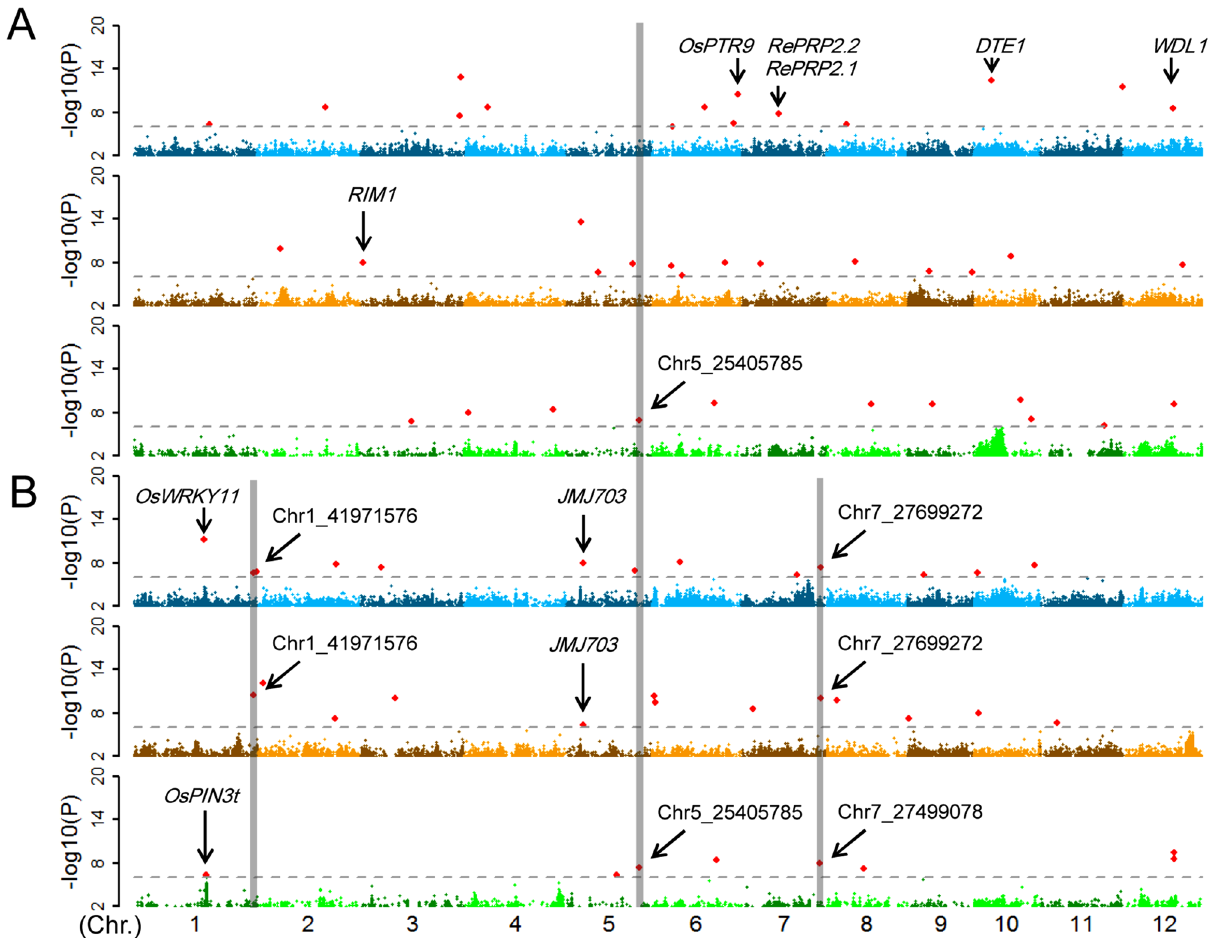
Figure 3. identification of root weight and shoot weight QTLs by GWAS. Manhattan plots in full population (blue), indica (yellow) and japonica (green) for ( A ) root weight and ( B ) shoot weight. Nine known genes around corresponding association signals were marked, together with one comment signal (Chr5_25405785) and two signal-enriched clusters for shoot weight (Chr1_41971576, Chr7_27699272 and